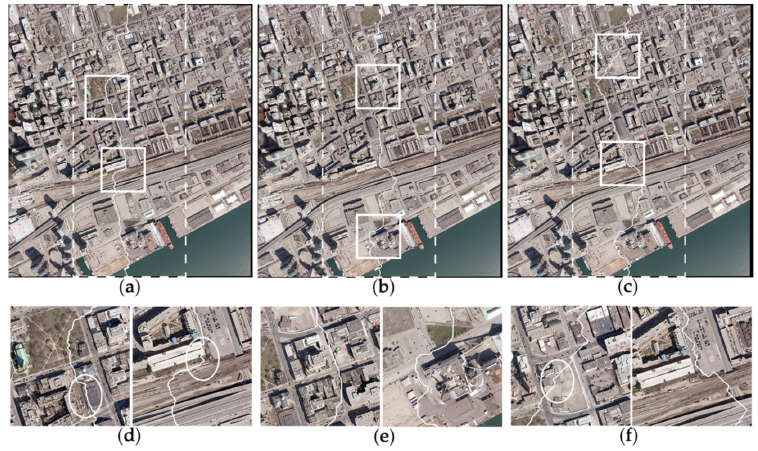
Figure 10. Results of seamline extraction and image mosaicking. ( a ) Seamline (white line) extracted by the Dijkstra’s algorithm with difference image; ( b ) seamline extracted by the proposed algorithm; ( c ) seamline extracted by the Dijkstra’s algorithm with processed DSM; ( d – f ) are enlarged display of the white rectangle areas in ( a – c ), respectively. The white circles show that the seamline crossed some